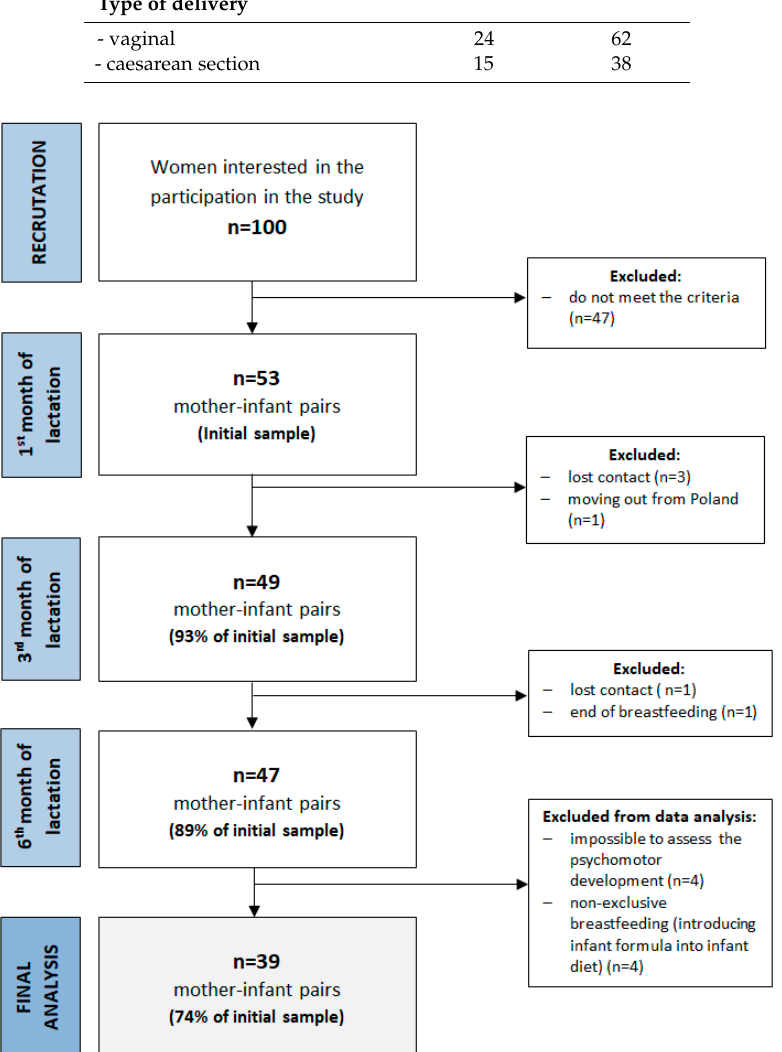
Figure 1. A flowchart of the study design and study sample collection.